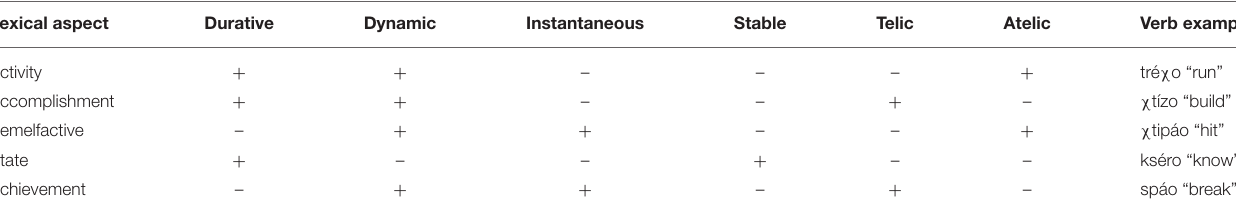
TABLE 2 | Summary of verb categories in lexical aspect together with their temporal features and examples in Greek. Lexical